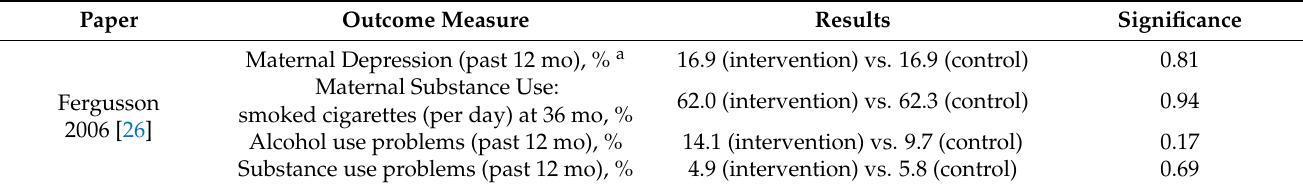
Table 5. Parental health and wellbeing.